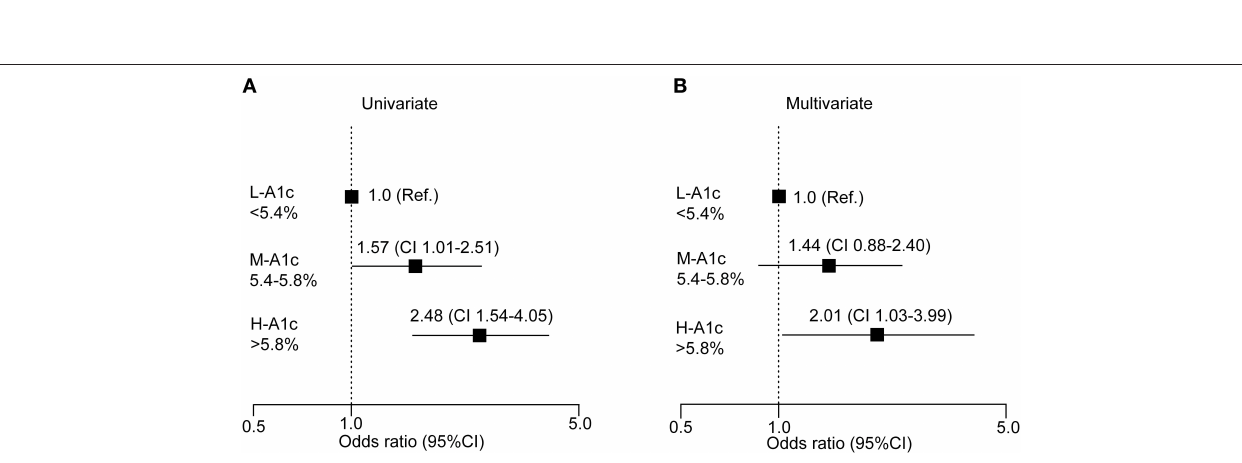
Frontiers in Endocrinology |